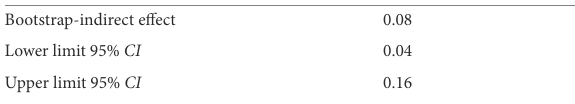
TABLE 6 Indirect effects of intrapreneurship (via creative self- efficacy) on opportunity recognition. Path